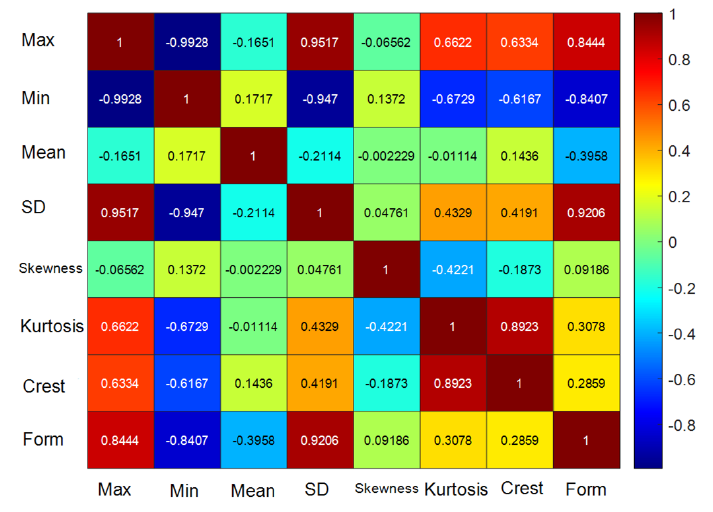
Figure 4. The correlation matrix had eight features.